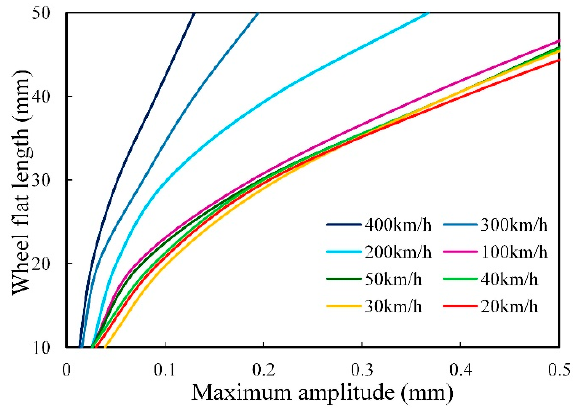
Figure 14. The relation curves between the maximum amplitude of the wheel flat and the flat length.